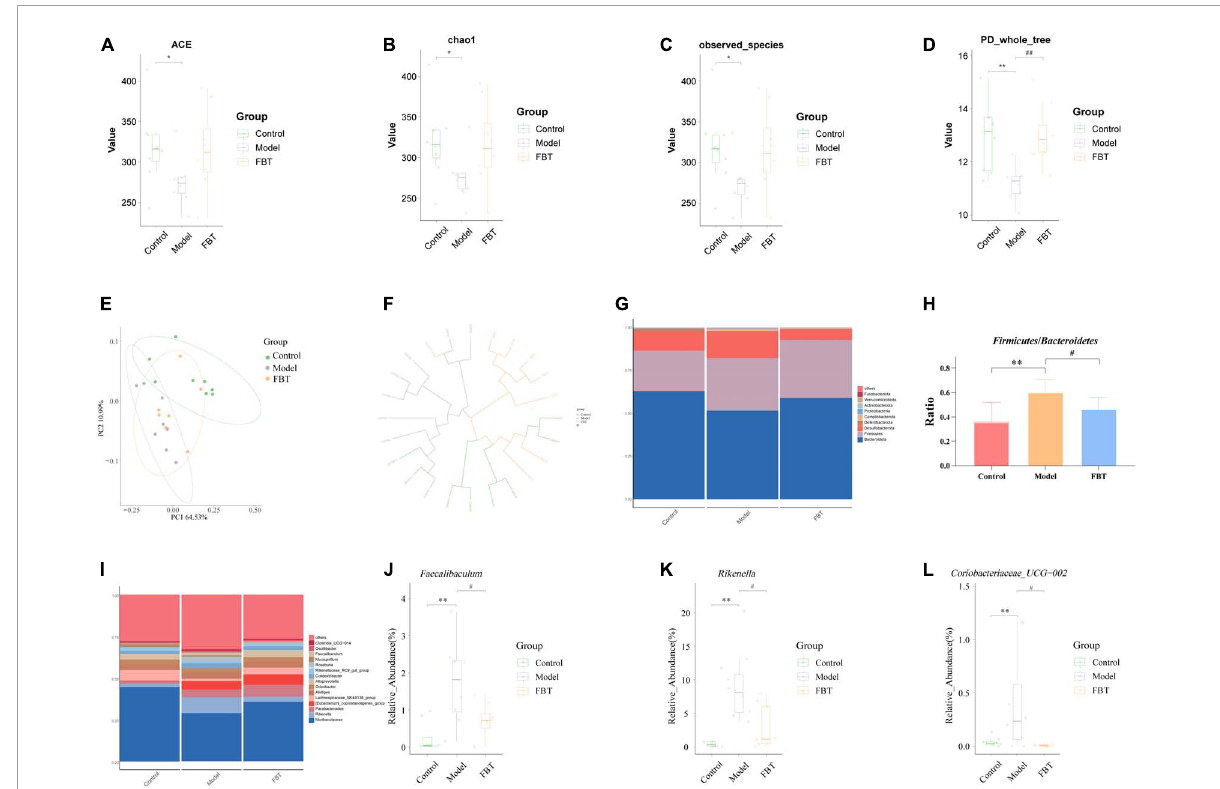
FIGURE4 Effects of FBT on gut microbiota diversity and abundance of NAFLD mice. (A) ACE index was increased in NAFLD mice after treatment with FBT; (B) Chao1 index was increased in NAFLD mice after treatment with FBT; (C) observed species index was increased in NAFLD mice after treatment with FBT; (D) PD_whole_tree index was increased in NAFLD mice after treatment with FBT; (E,F) PCoA and UPGMA showed more similar beta diversity between the FBT group and control groups than that between the model and control group; (G,H) at the phylum level, FBT treatment increased the Bacteroidetes / Firmicutes ratio in NAFLD mice; (I–L) at the genus level, FBT treatment increased the abundances of Faecalibaculum , Rikenella , and Coriobacteriaceae_UCG-002 . N = 8. * P < 0.05, ** p < 0.01 vs. control group. # P < 0.05, ## p < 0.01 vs. model